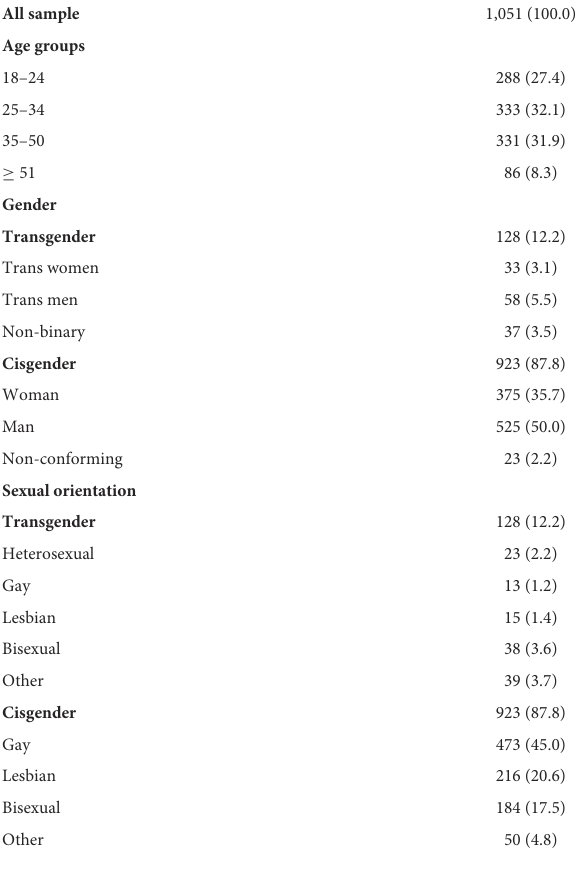
TABLE 1 Characteristics of the LGBT